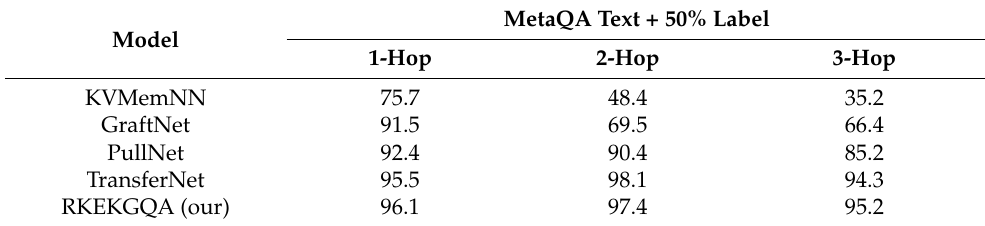
Table 5. Hit@1 results on MetaQA of the mixed